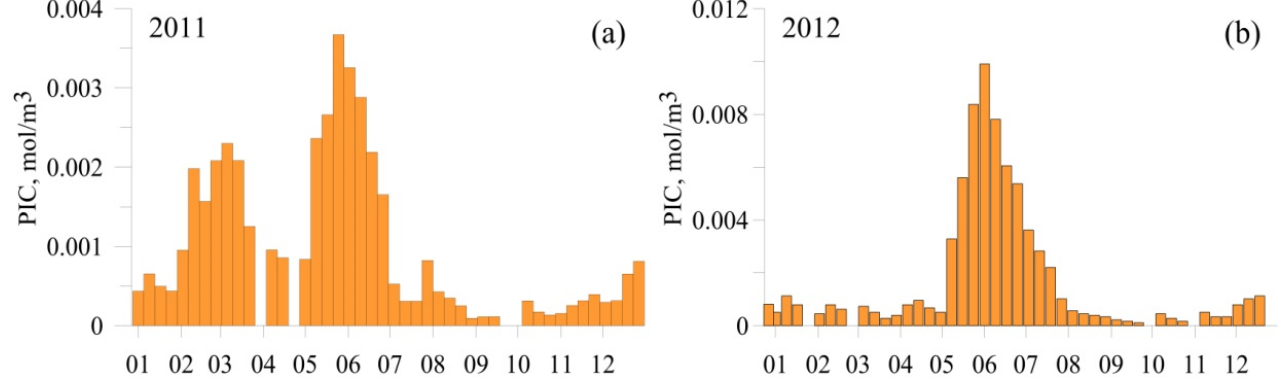
Figure 18. Dynamics of coccolithophores during winter and summer blooms assessed by PIC concentration in the years with warm ( a ) and cold ( b ) winters according to the MODIS-Aqua.